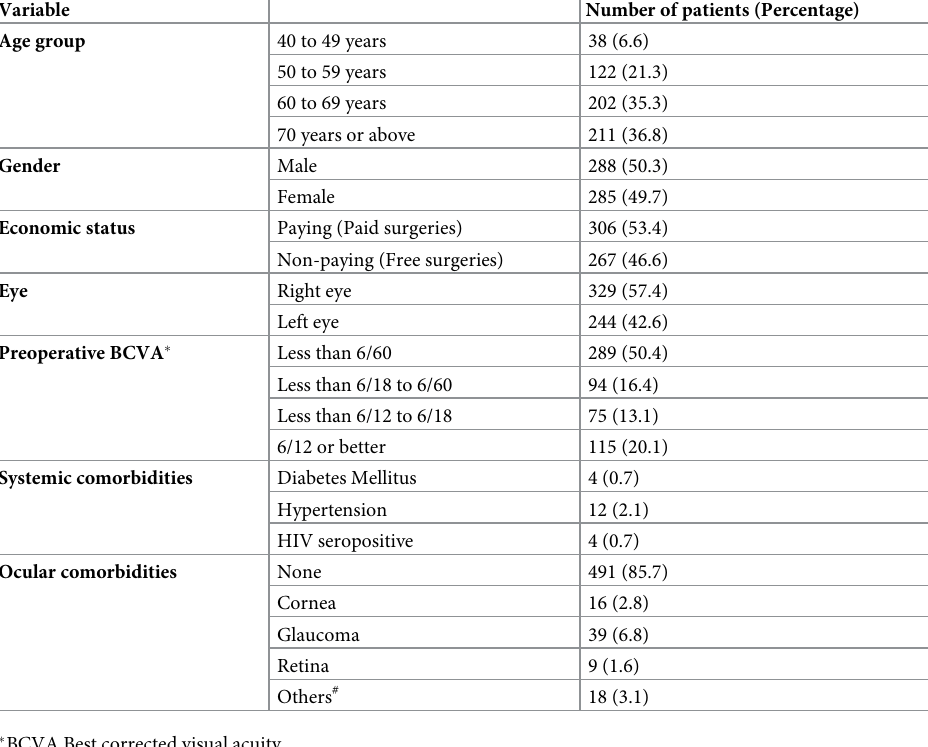
Table 1. Demographics and baseline characteristics of the patients who underwent cataract surgery.